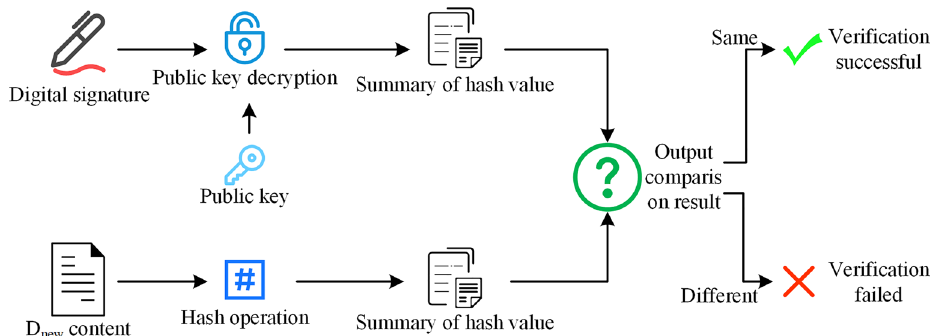
Figure 9. Digital signature verification